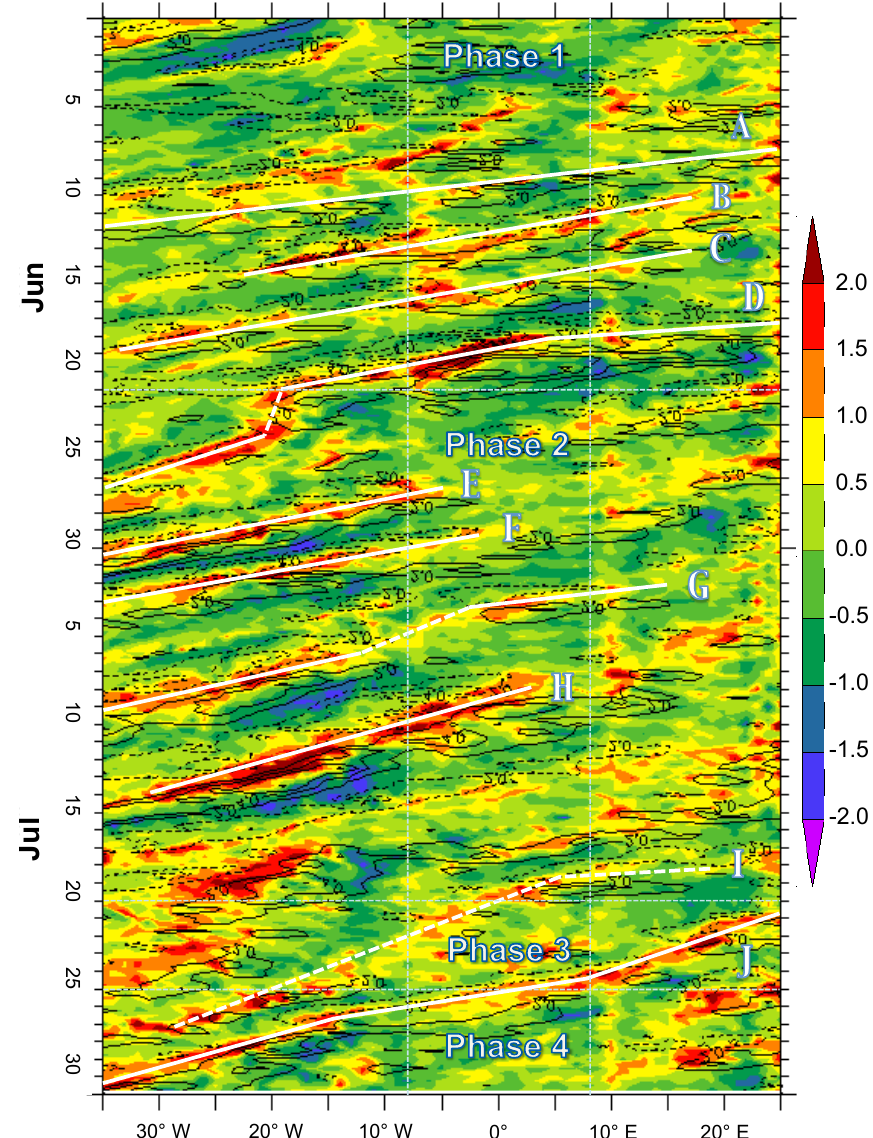
Figure 9. Coherent wind and vorticity features affecting the DACCIWA region. Hovmöller diagram showing 4–18 ◦ N meridionally averaged vorticity (colours, 10 − 5 s − 1 ) and meridional wind (black lines, ms − 1 ) based on operational ECMWF analyses at 1 ◦ resolution (in order to smooth noisy vorticity fields). The four phases of the DACCIWA campaign and significant synoptic-scale features A–J are marked as well as the longitudinal bounds of the DACCIWA focus region 8 ◦ W–8 ◦ E (see Fig.